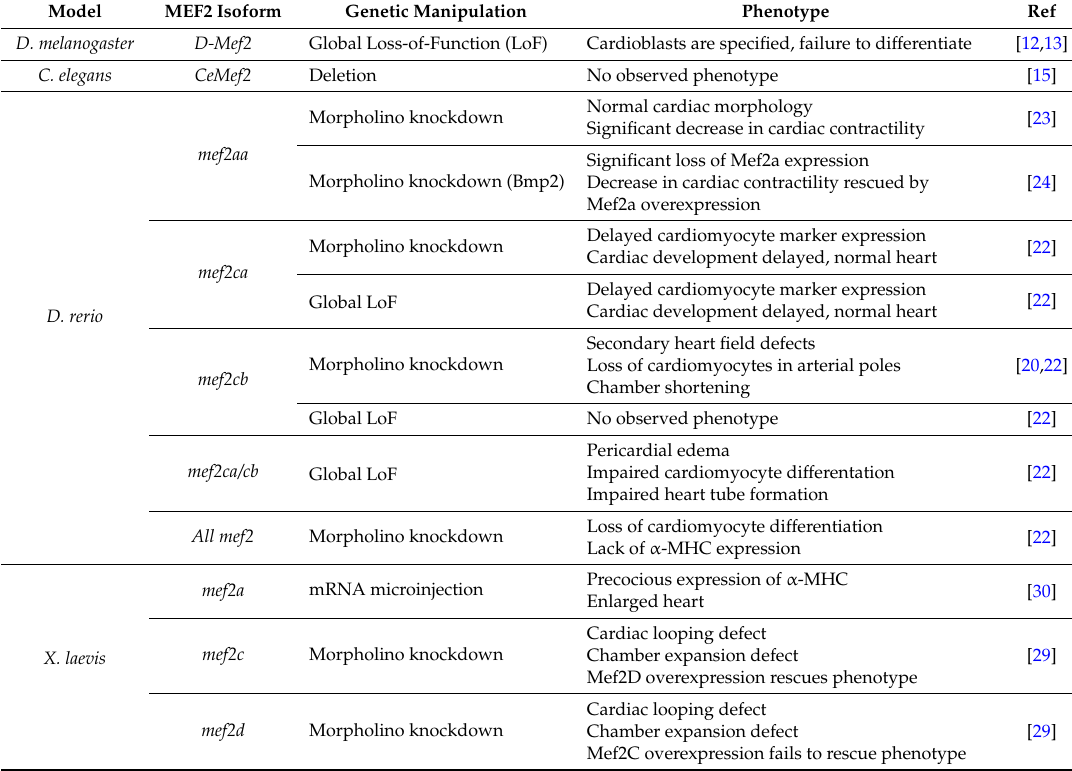
Summary of cardiac-related phenotypes of MEF2 family transcription factor family misexpression in model systems with one, two, and three-chambered